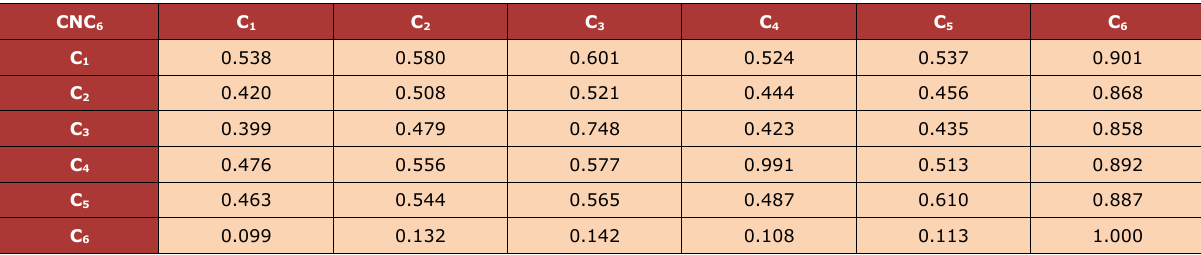
Table 15. Pair-wise comparison of criteria with respect to A